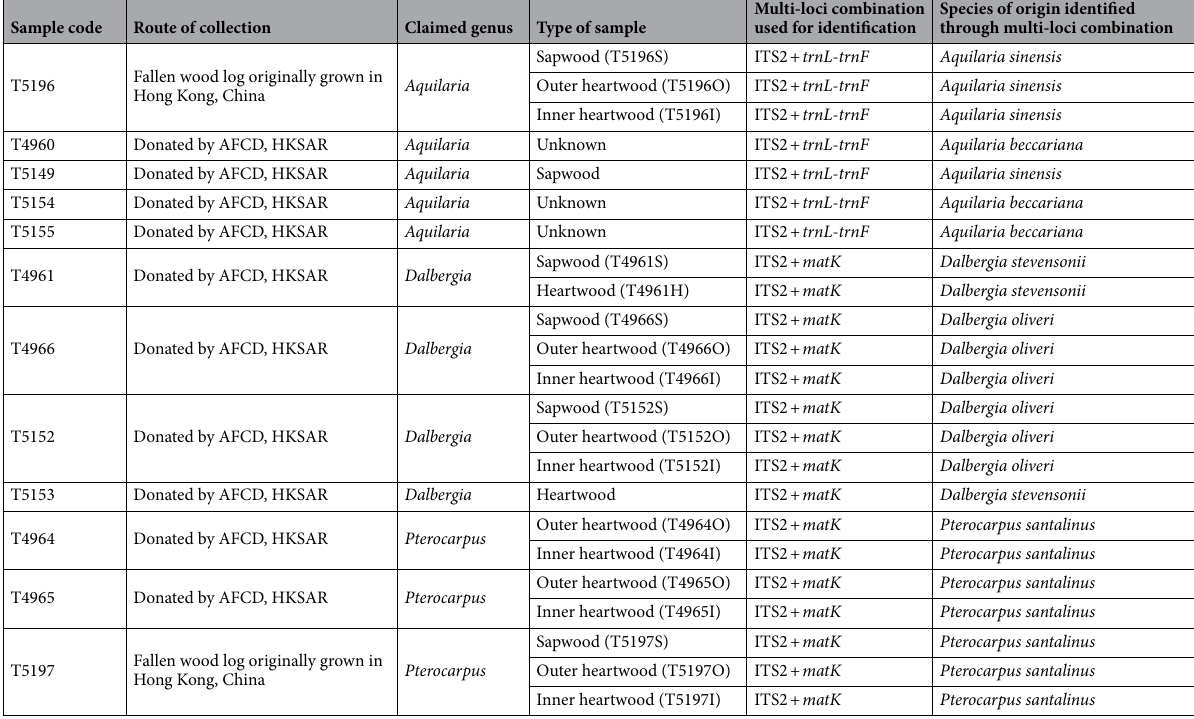
Table 1. List of authentic wood samples